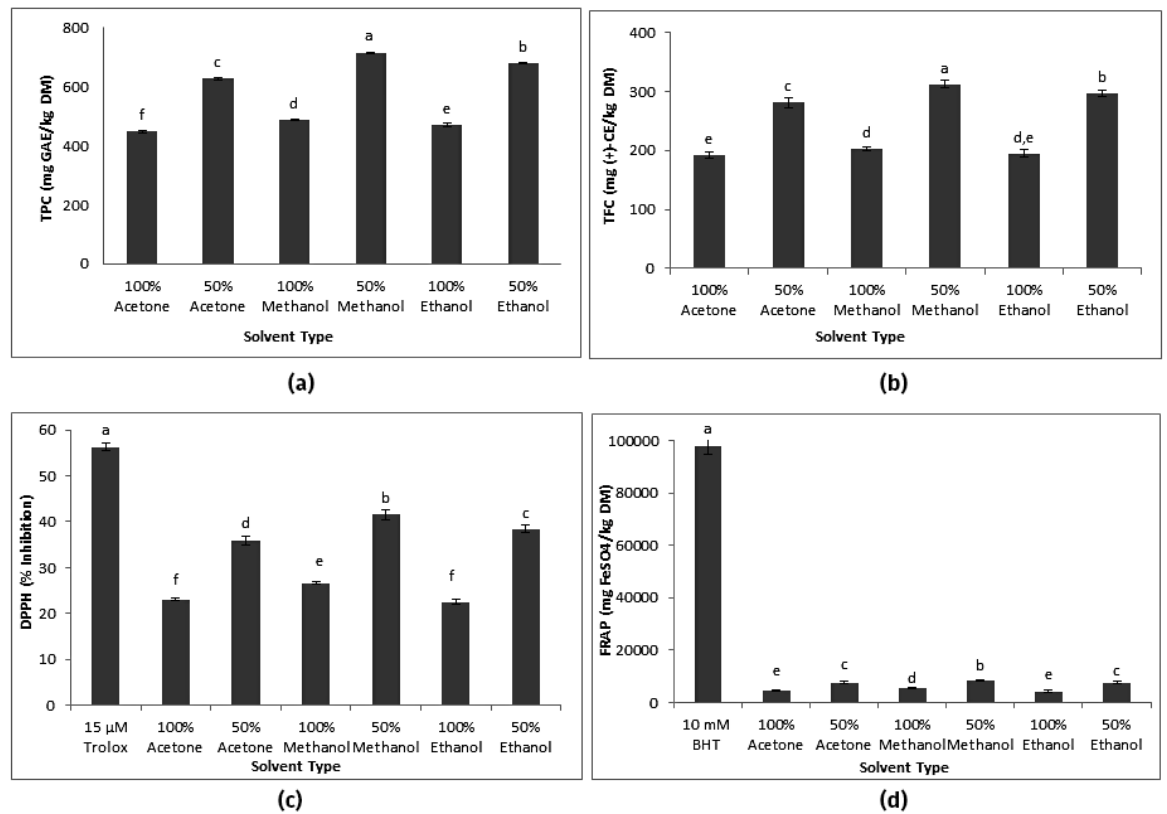
Figure 1. TPC a , TFC b , DPPH radical scavenging activity (% inhibiton) c and FRAP d values of fig seeds extracted with various solvents (n = 3 ± S.D.). Values marked with the different lower case letters (a–f) are significantly different from each other at p